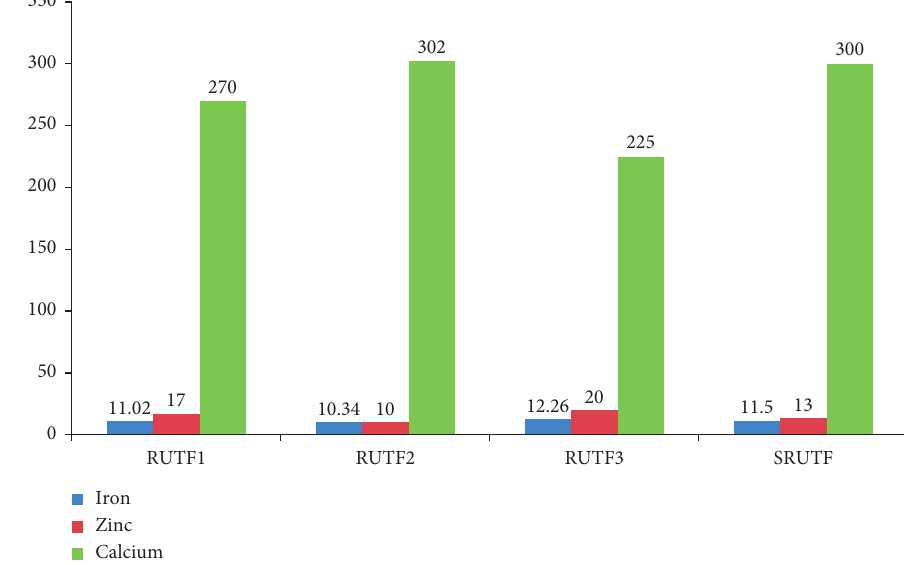
Figure 1: Comparison of the minerals with the standard ready to use therapeutic foods (SRUTF).